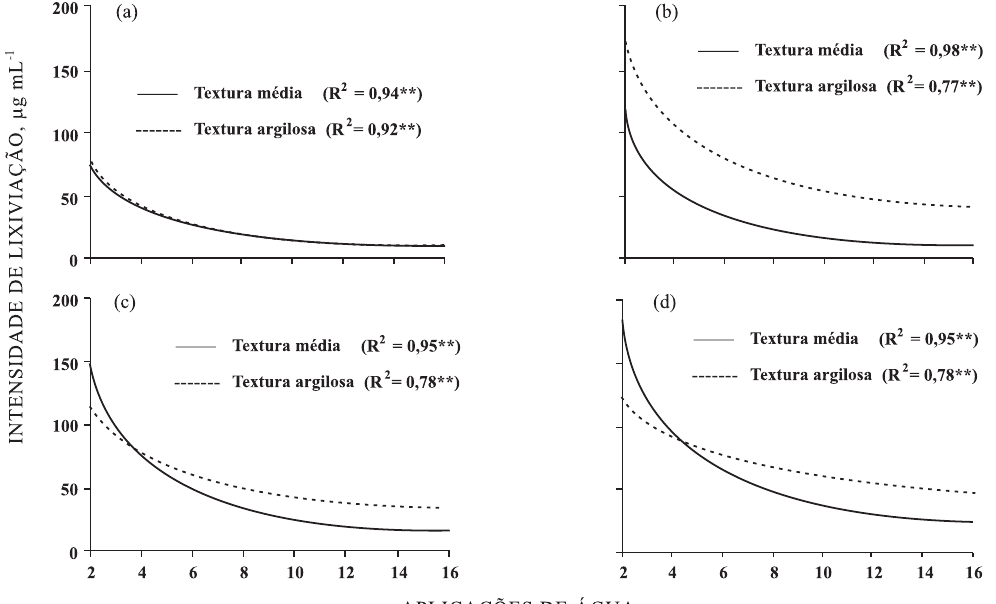
Figura 2. Intensidade de potássio percolado nas doses 0, 60, 120 e 180 kg ha -1 de K respectivamente), complementadas com 80 kg ha -1 de K de solo. **: significativo a 1